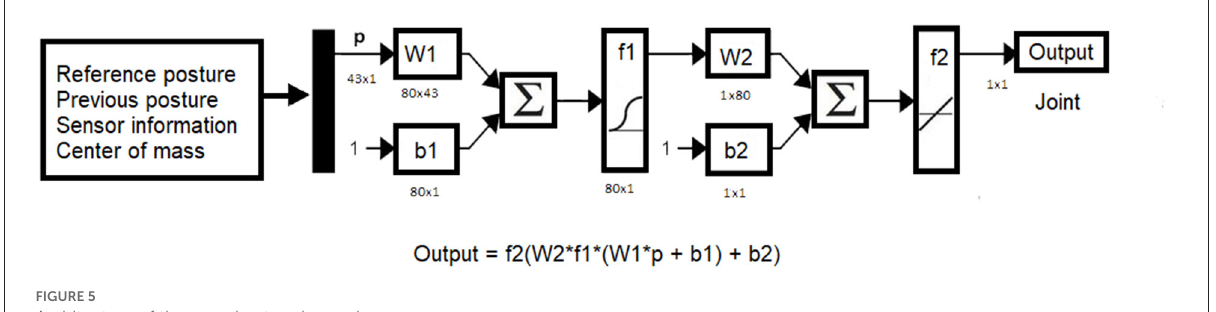
FIGURE5 Architecture of the neural networks